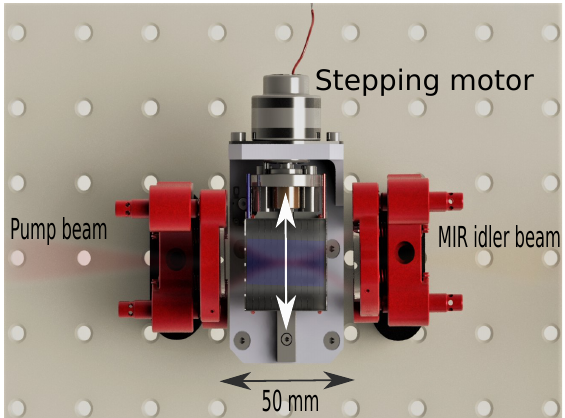
Figure 2. The MIR OPO is optimized for operation in the spectral region between 2.9 µ m and 3.6 µ m. The linear cavity consists of spherical mirrors each with a radius of curvature of 100 mm separated by 50 mm. The pulsed MIR source is characterized by a repetition rate of 12.448 kHz, a pulse duration of 40 ns, and a potential average output power in excess of 400 mW. A computer is controlling ∼ the stepping motor and temperature of the nonlinear crystal: a 30 lithium niobate bulk crystal with a chirped fan-out structure of poling periods ranging from 27.4 µ m to 31.75 µ m.